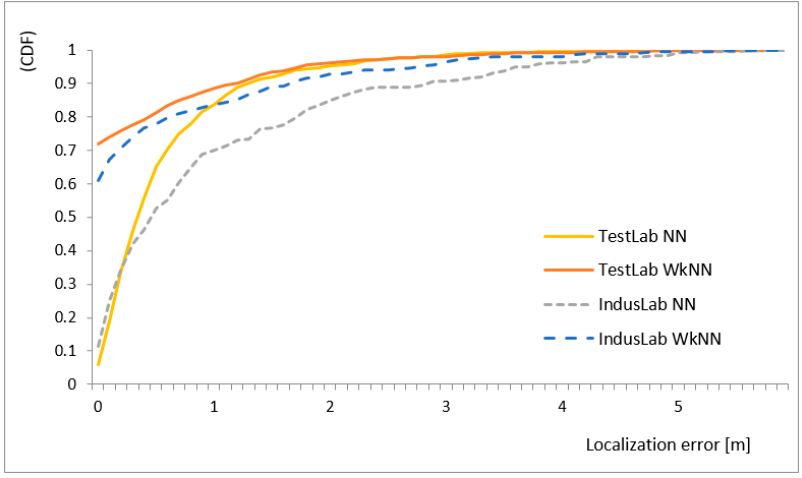
Figure 9. Comparison of localization accuracy for points with known RSSI values.